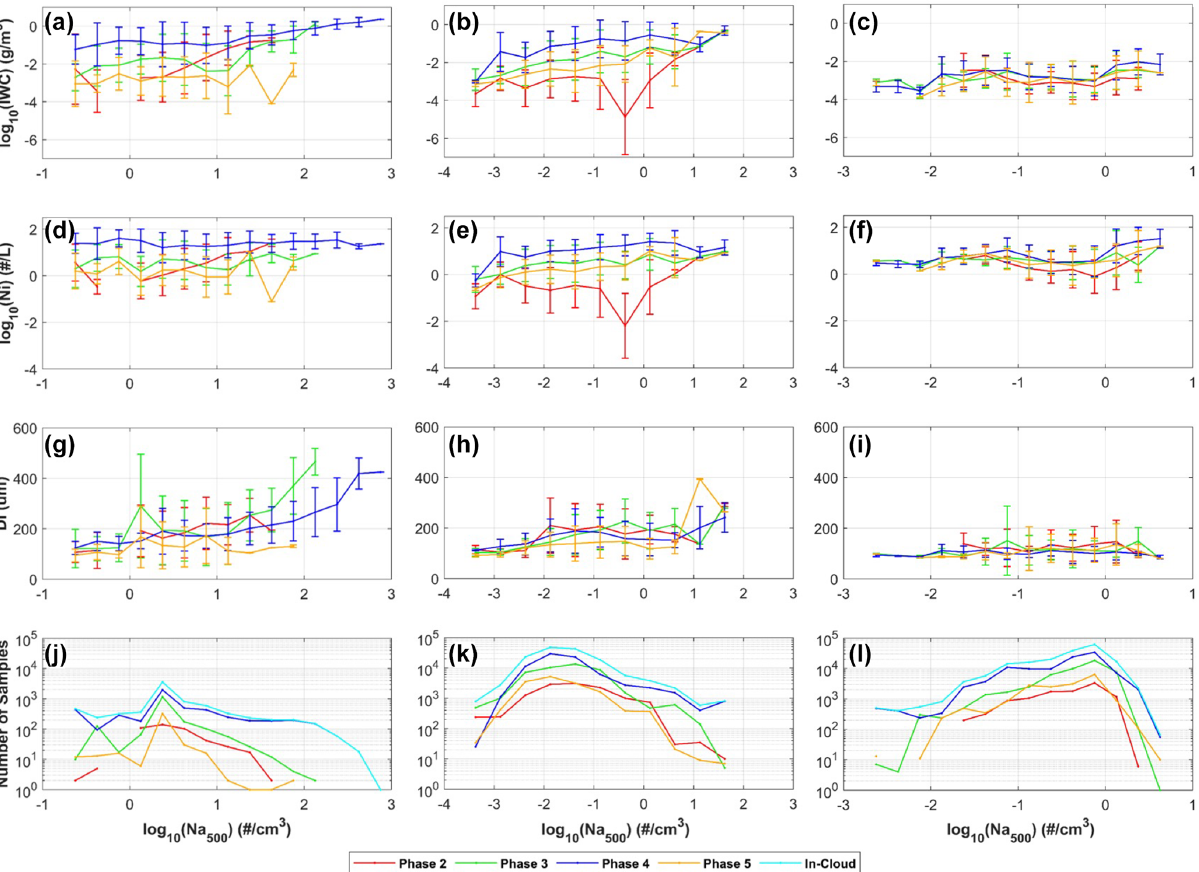
Figure 9. Similar to Fig. 8, except for plotting cloud microphysical properties against log 10 (Na 500 ).